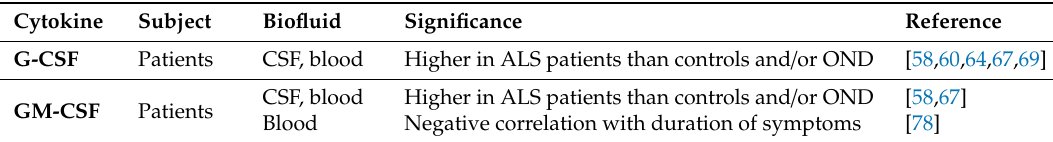
Table 4. Colony stimulating factors (CSFs) found dysregulated and proposed as biomarkers in biofluids from ALS